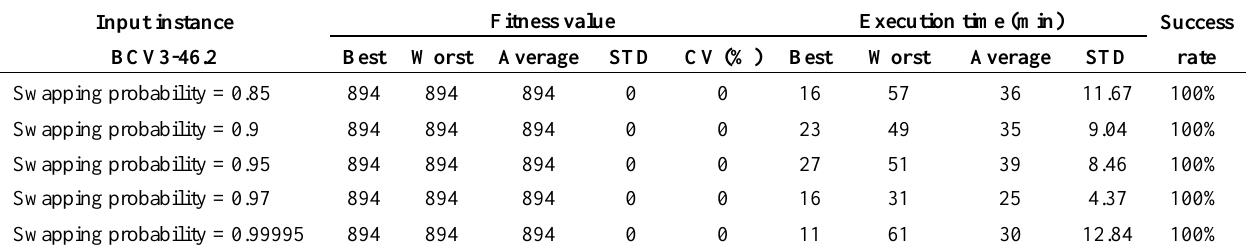
Table 10. Investigating the effect of swapping probability for input instance, BCV3-46.2.